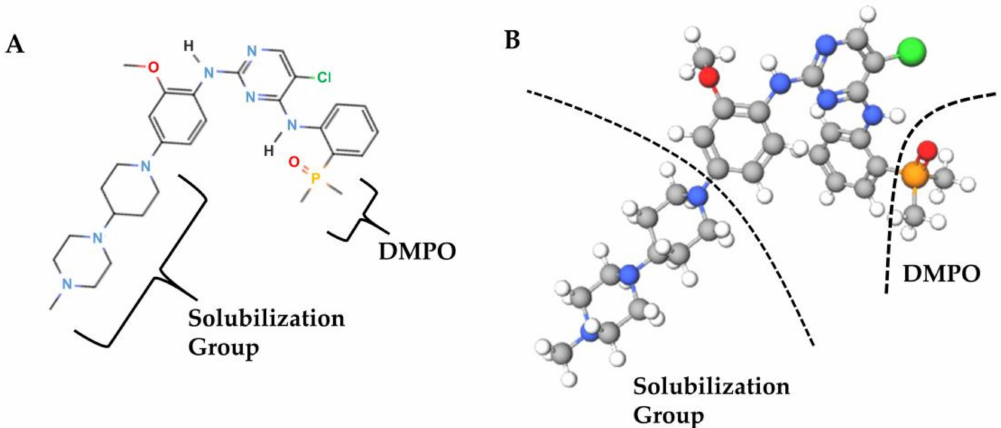
Figure 8. Brigatinib ( A ) and a ball-and-stick representation of brigatinib ( B ). Brigatinib has a dimethylphosphineoxide(DMPO)group, afeaturenotfoundinotherALKinhibitors. Thesolubilization group imparts a high water solubility and low lipophilicity to brigatinib. The colors of the element symbols in the structural formula ( A ) correspond to the colors of the elements in the ball-and-stick representation. Only the hydrogen molecule is shown in black in the structural formula, and in white in the ball-and-stick